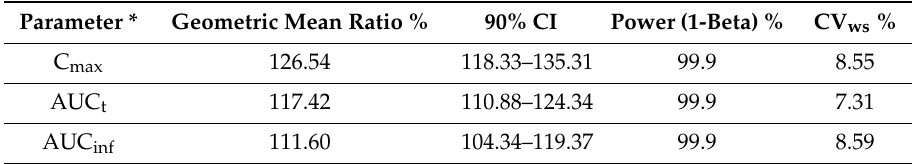
Table 1. Summary results of the pilot bioequivalence study ( N = 11).